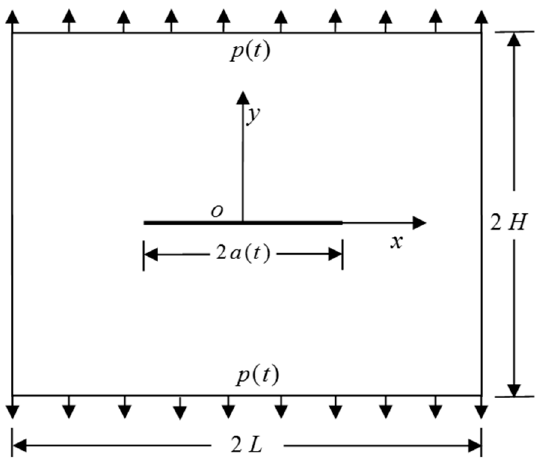
Figure 7. The Griffith specimen.